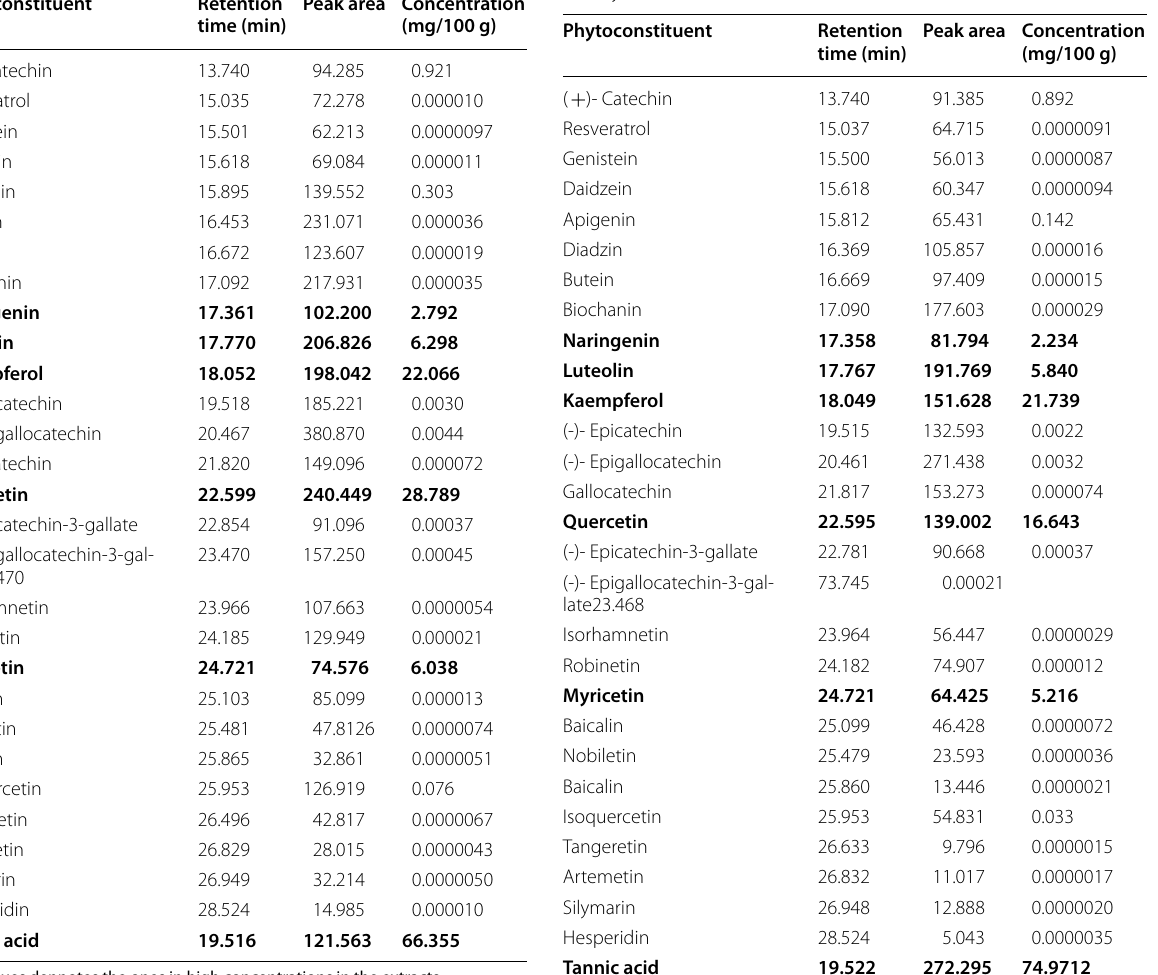
Table 10 Phytochemical components identified in the most active (ethyl acetate) fraction of methanol extract of I. gabonensis leaf by GC-FID